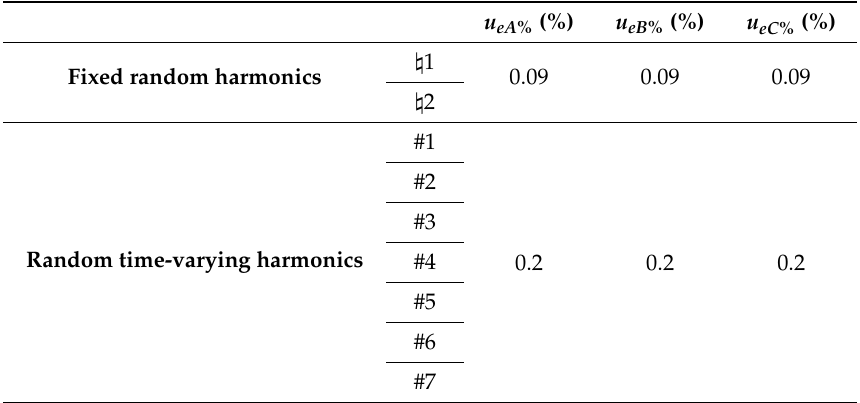
Table 7. Evaluation of Standard Uncertainty for the EMUTs additional percentage errors.